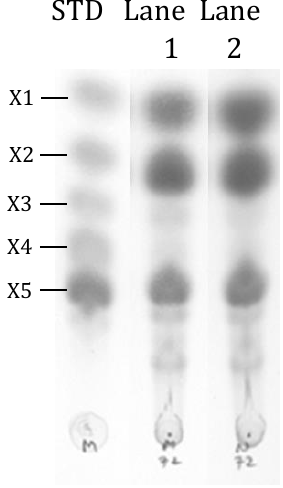
Figure 1. Thin-layer chromatography (TLC) results showing the primary hydrolysis products of alkali-pretreated EFB using XYN10Ks_480 endoxylanase produced from recombinant S. lividans 1326 in 72 h. Lane 1: Using the unconcentrated XYN10Ks_480 endoxylanase; Lane 2: Using XYN10Ks_480 endoxylanase concentrated by NF xylooligosaccharides (XOS) standards (STD); X1, xylose; X2, xylobiose; X3, xylotriose; X4, xylotetraose; X5, xylopentaose.